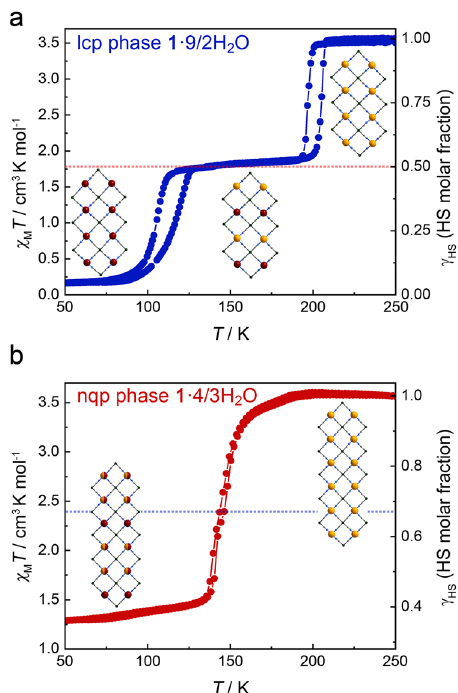
Fig. 4 Temperature dependence of the χ M T curves of lcp phase 1·9/2H 2 O and nqp phase 1·4/3H 2 O upon heating and cooling. The two-step SCO with a large plateau of lcp phase 1 ·9/2H 2 O ( a ) and a two-step SCO without plateau of nqp phase 1 ·4/3H 2 O ( b